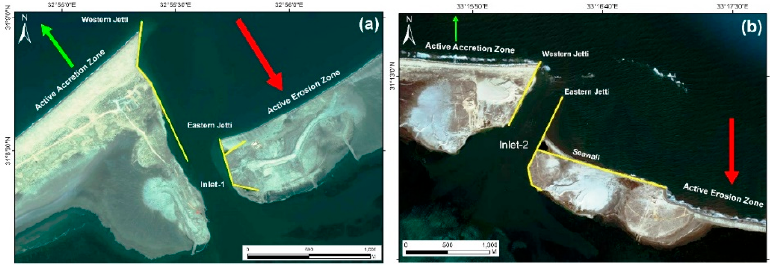
Figure 13. Coastal Structure along the Bardaweil Artificial Inlets ( a ) Inlet-1 ( b ) Inlet-2. The green arrow refers to the accretion zone behind the western Jetty, while the red arrow refers to active erosion zone downward.